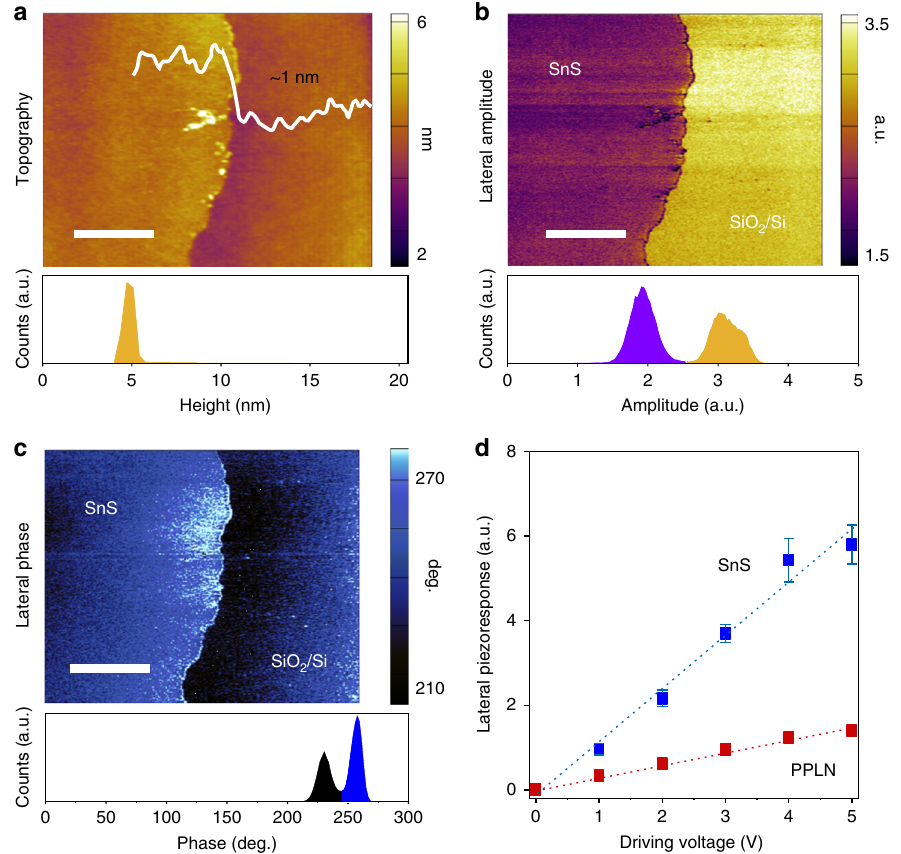
Fig. 3 Lateral piezoelectric response of the monolayer SnS. a Topography of the monolayer sheet with the height pro fi le illustrating sheet thickness of ~1 nm, which is approximately a monolayer. This is also con fi rmed by the histogram showing the height distribution. b Lateral amplitude of the SnS monolayer with inset of histogram. c Lateral phase of the SnS monolayer with inset of histogram. d Lateral piezoresponse of monolayer SnS and PPLN vs the driving voltage. Scale bars are 2 µ m. Error bars denote the standard deviation of the